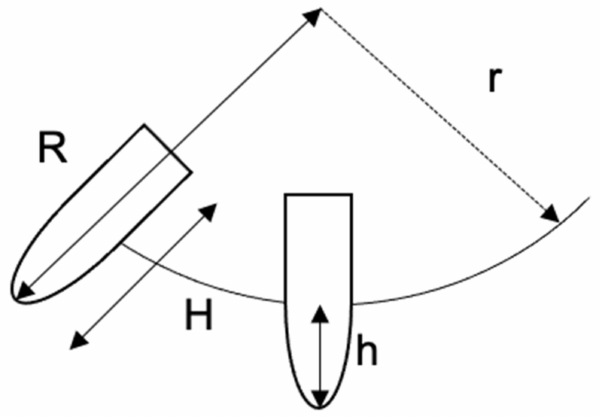
Figure 1. The principle of centrifuge method